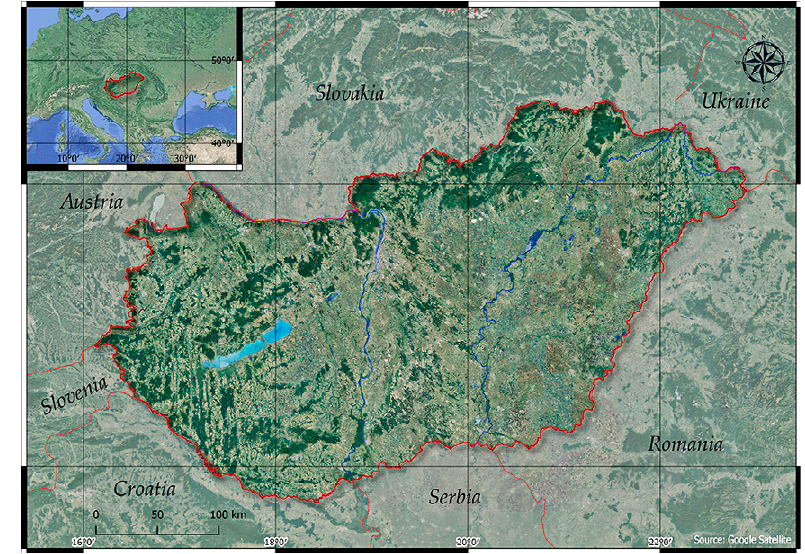
Figure 1. Study area: Hungary in East-Central